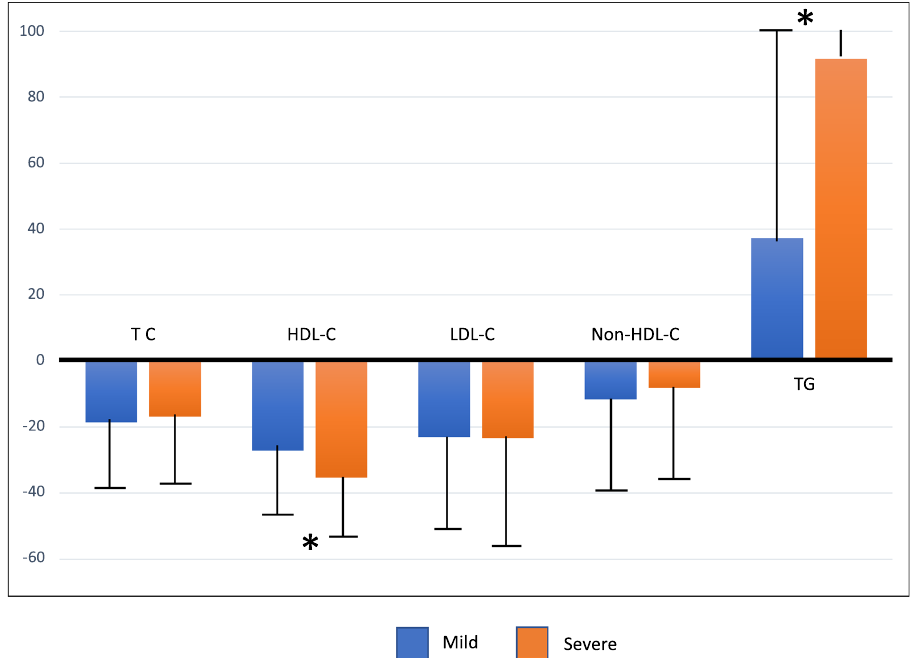
Figure 3. Percentage variation of mean (SD) lipid values in the group with data before and during hospitalization sorted by COVID-19 severity. TC total cholesterol, TG triglycerides; *p < 0.001.